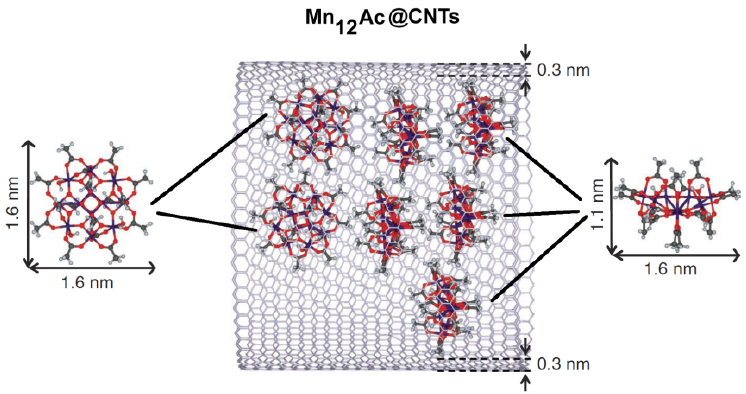
Figure 2. Chemical structure of Mn representation of its encapsulation in a carbon